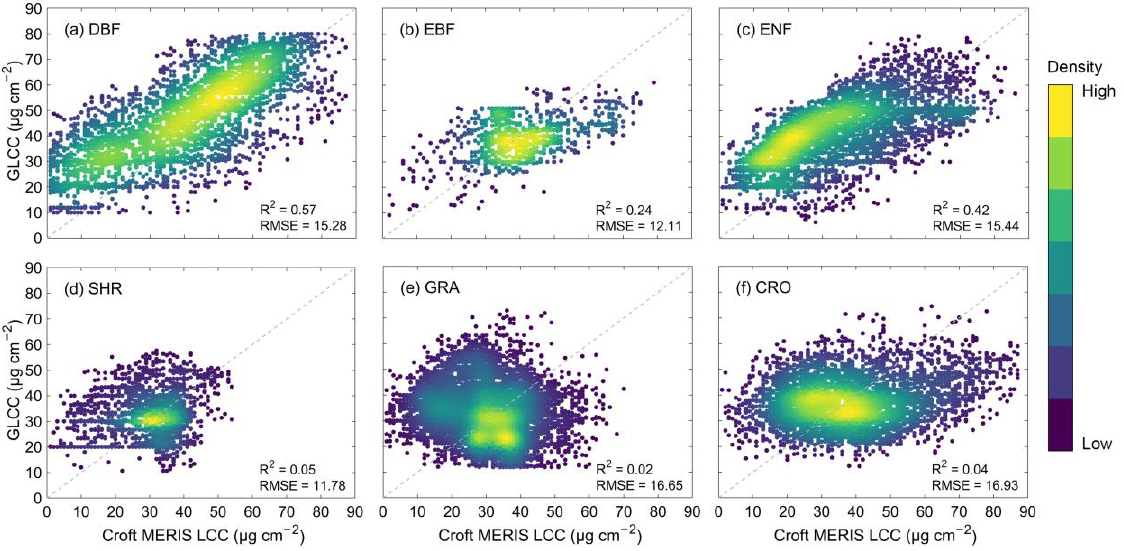
Figure 9. Comparisons of GLCC and Croft MERIS LCC in six different PFTs at the cross-validation sites.